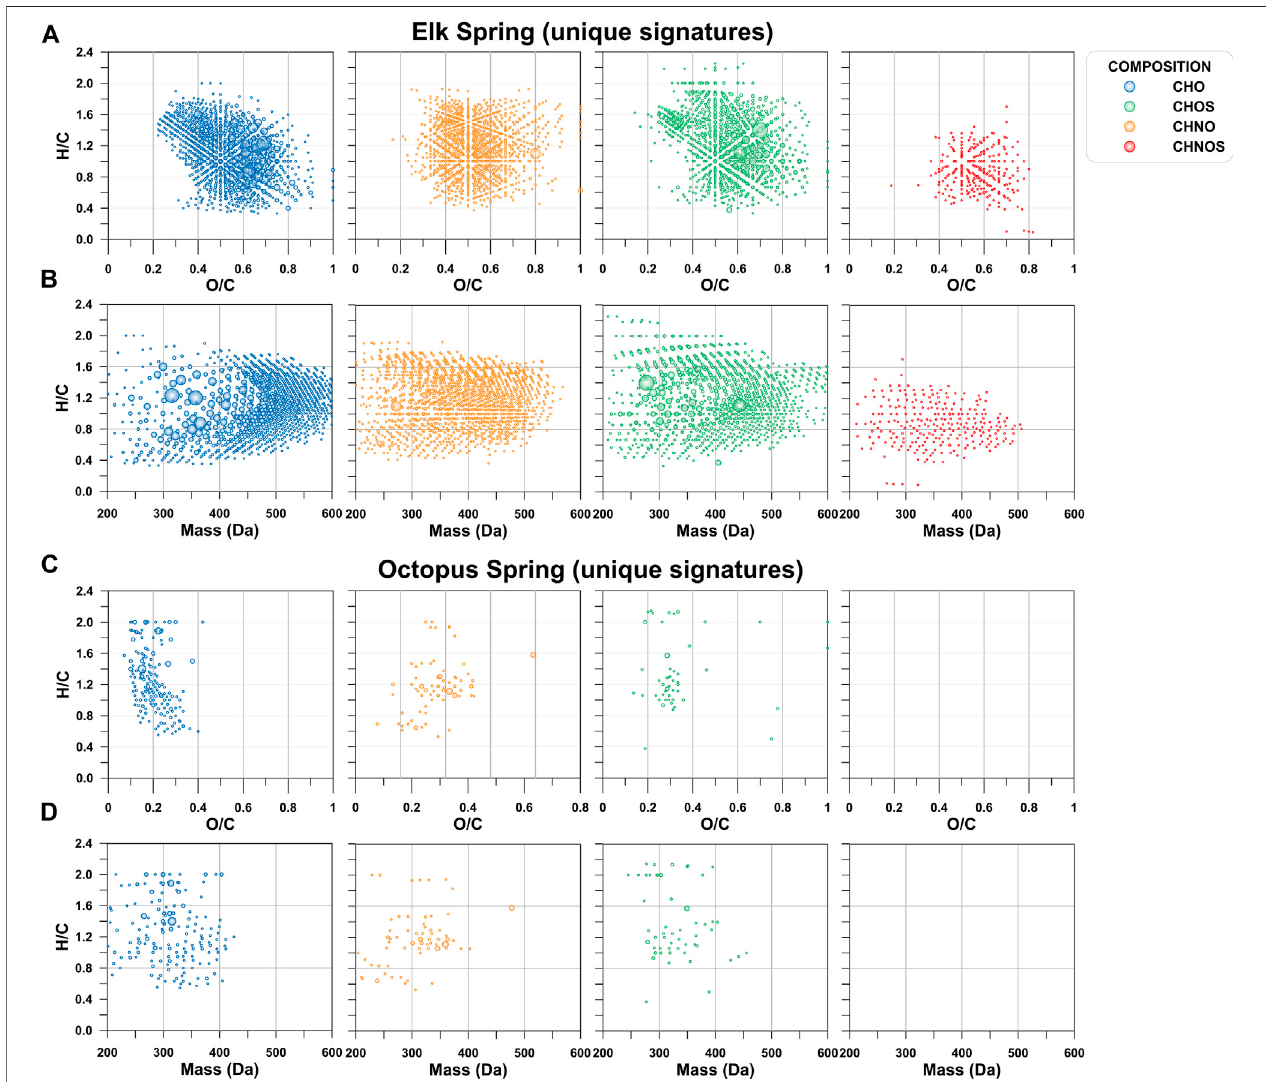
FIGURE8| Uniquesignaturesdepicted byvanKrevelen diagrams and mass-edited H/C ratioplots. (A) vanKrevelendiagramforElkSpring. (B) .Mass-edited H/C diagram for Elk Spring. (C) . van Krevelen diagram for Octopus Spring. (D) . Mass-edited H/C diagram for Octopus Spring.